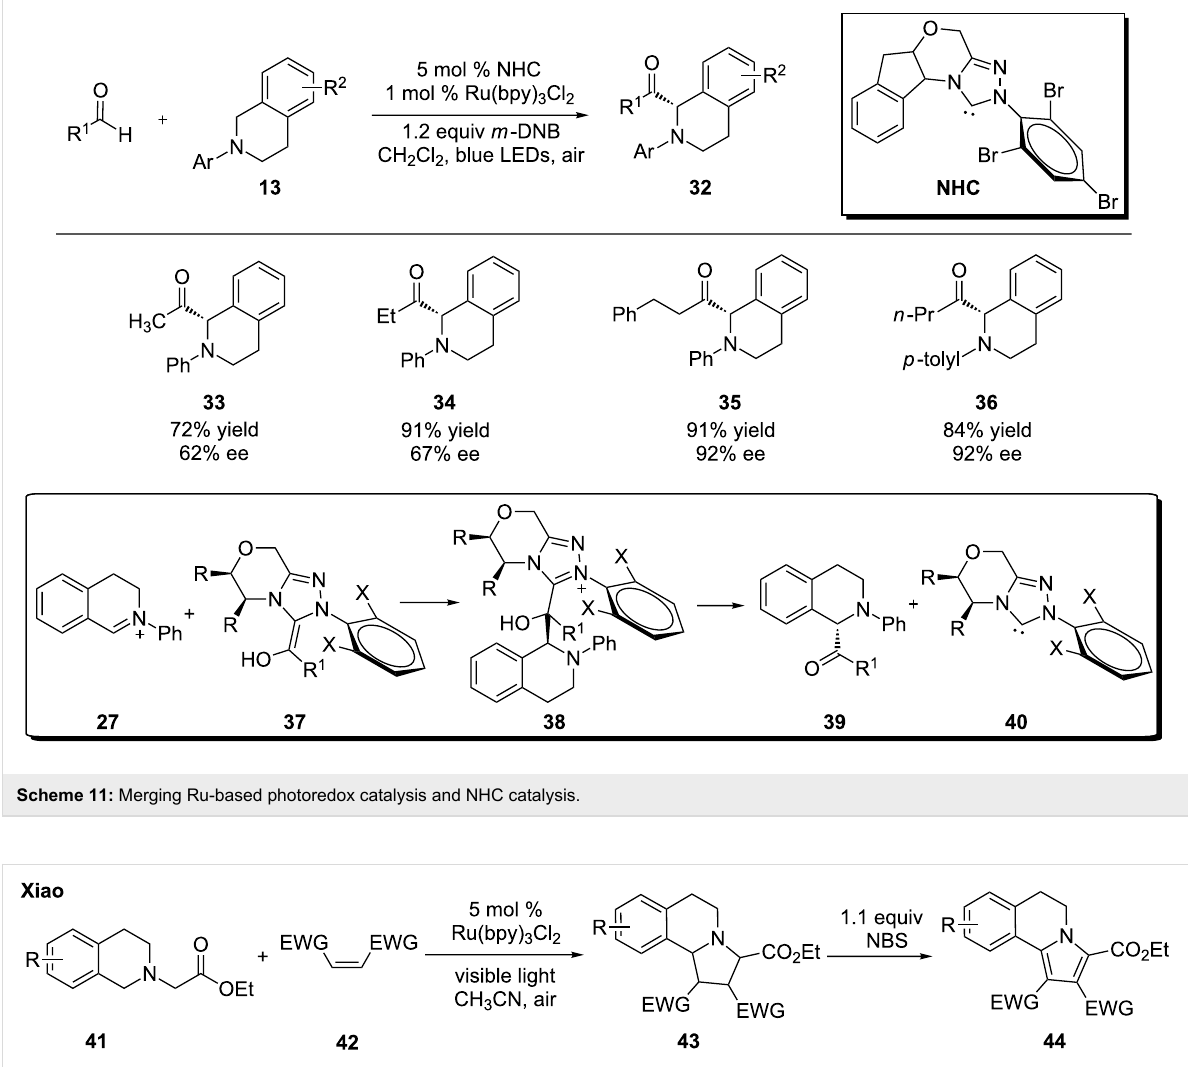
Scheme 11: Merging Ru-based photoredox catalysis and NHC catalysis.